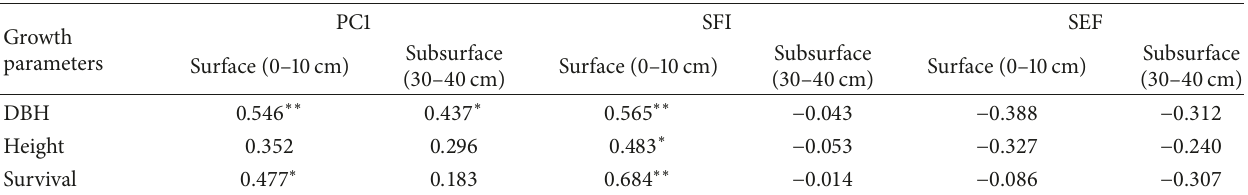
Table 4: Summary of the relationship between PC1 score, SFI, SEF, and tree growth parameters (diameter at breast height (DBH), height, and percentage of